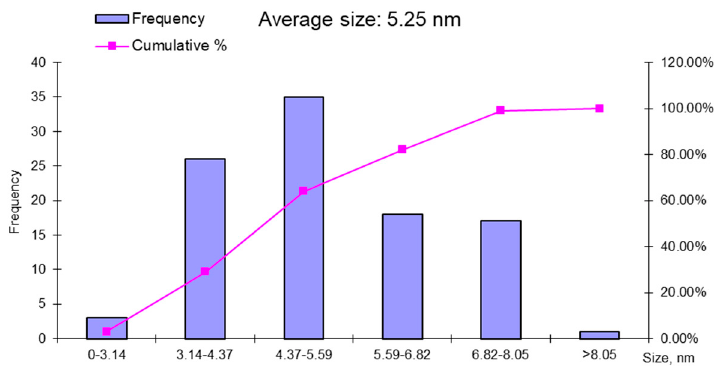
Figure 11. Histogram representing the distribution of the magnetite nanoparticles, as synthesized from the mill scale waste.